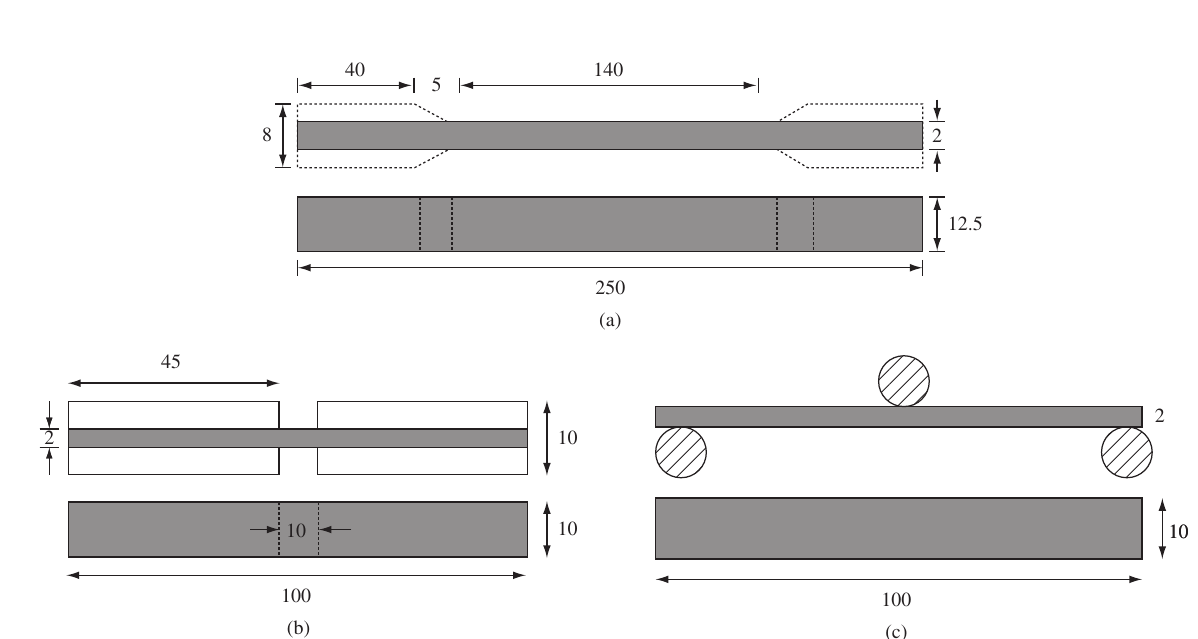
Figure 1. Schematic representation of specimen configuration used for: a) tensile; b) compression; and c) flexure testing. (All dimensions are in mm)